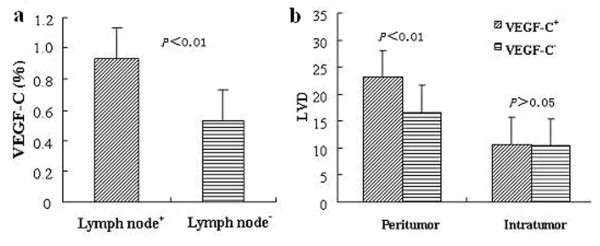
Prognosis analysis of vegf-c expression.